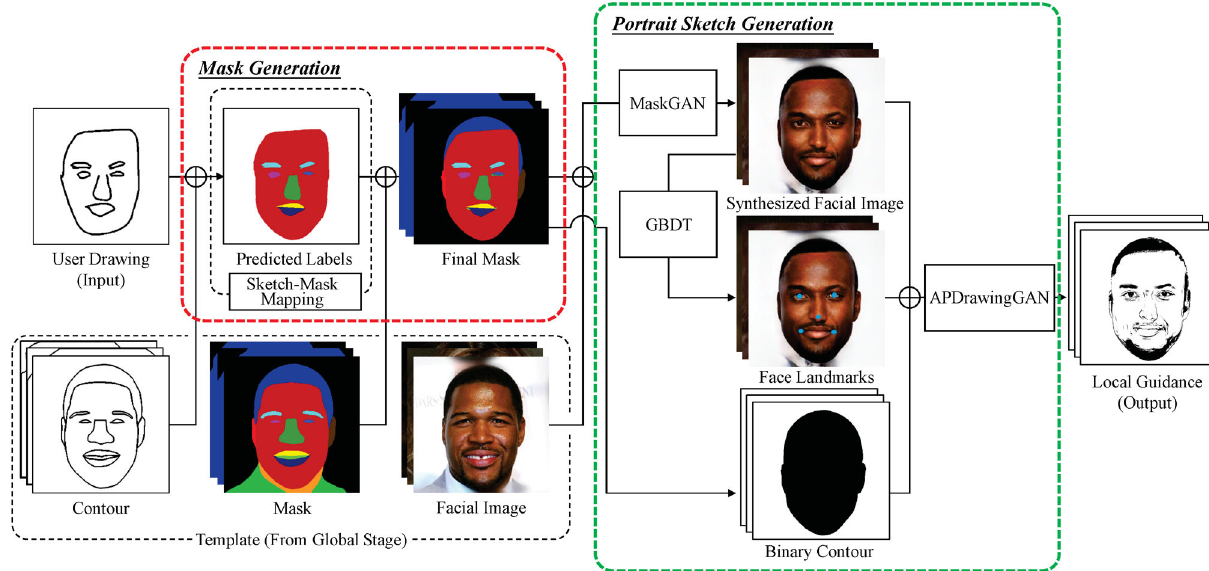
Fig. 4 Local guidance stage consists of two steps: mask generation and portrait sketch